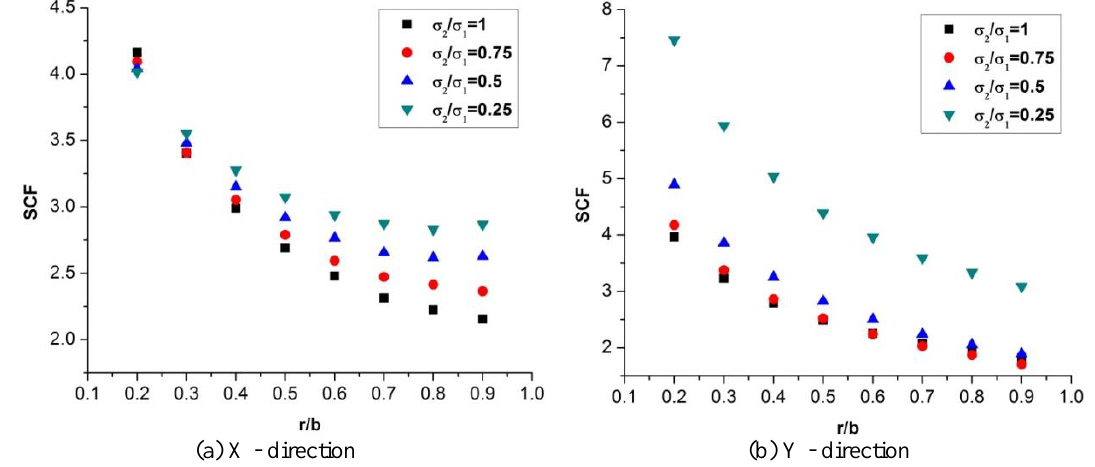
Figure 8. Variation of SCF with loading ratio for b/a =